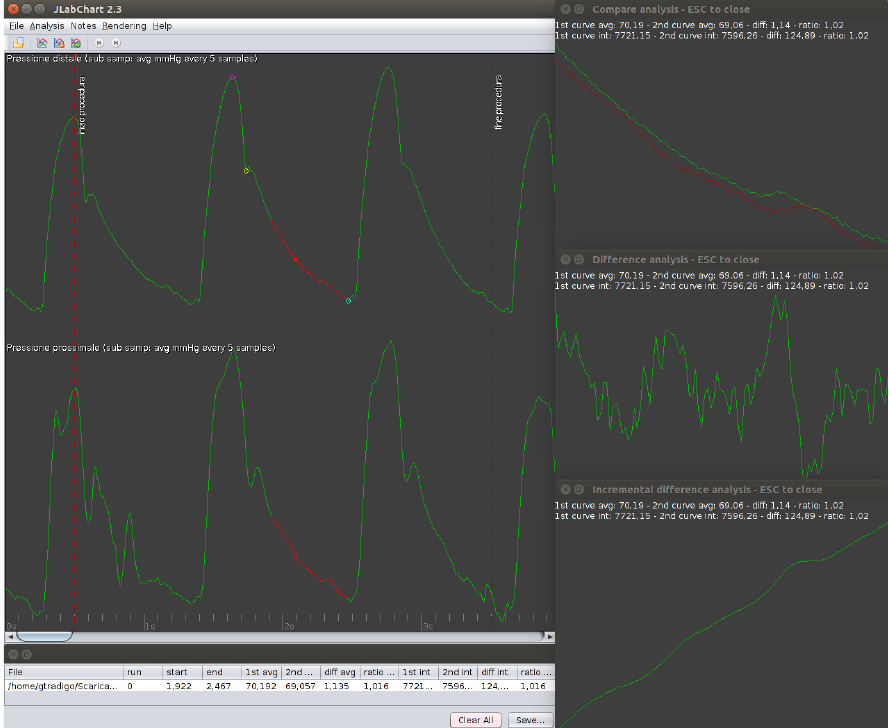
Figure 9. JLabChart Software tool. User interface with various visual and numerical signal